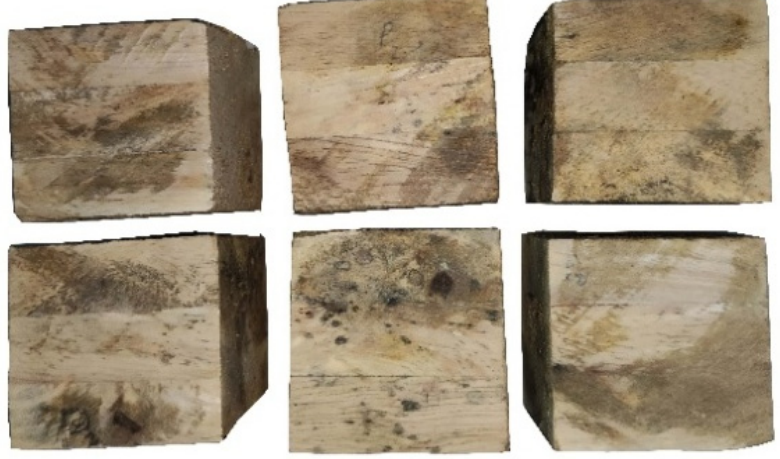
Figure 6. Tested delamination specimens in hot water of polystyrene rubber-wood glulam.